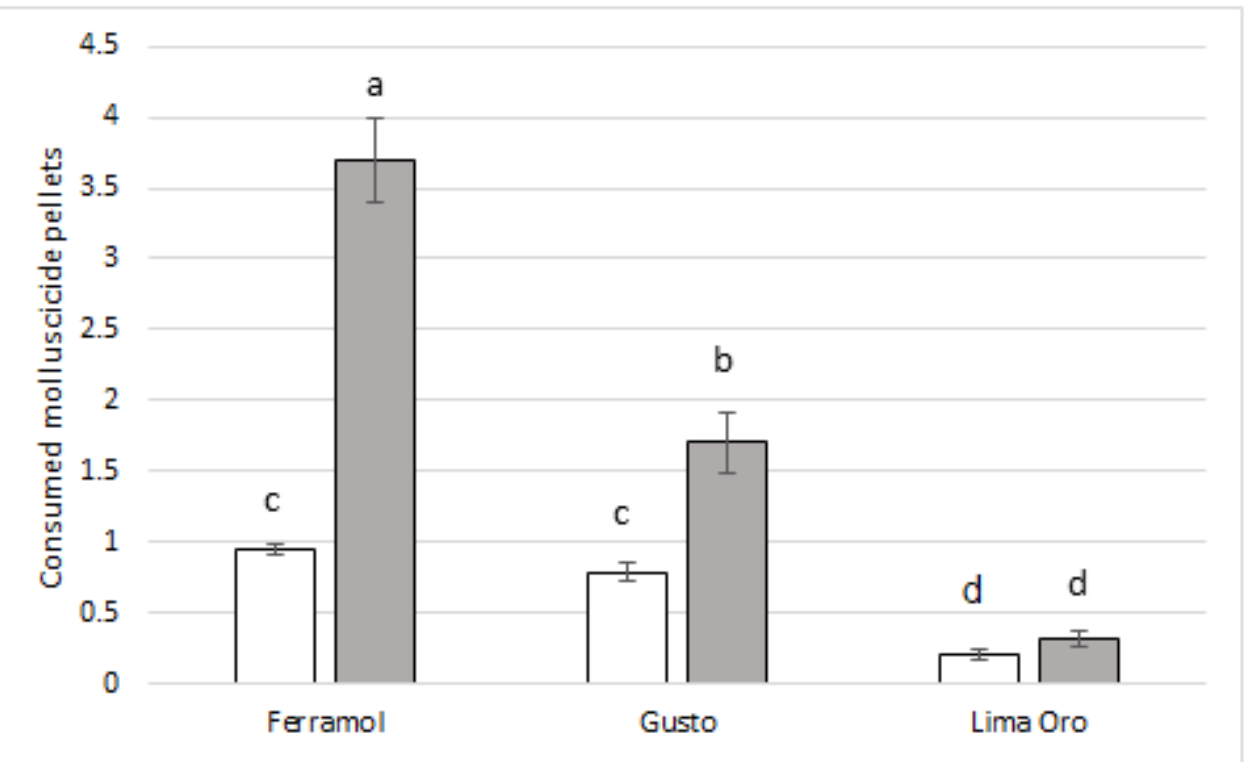
day of exposure. White bars indicate treatments with 1 pellet, while gray bars indicate treatments with 5 pellets. Ferramol 1 pellet ( n = 38), Ferramol 5 pellets ( n = 33), Gusto 1 pellet ( n = 40), Gusto 5 pellets ( n = 39), Lima Oro 1 pellet ( n = 34), and Lima Oro 5 pellets ( n = 30). Means with different